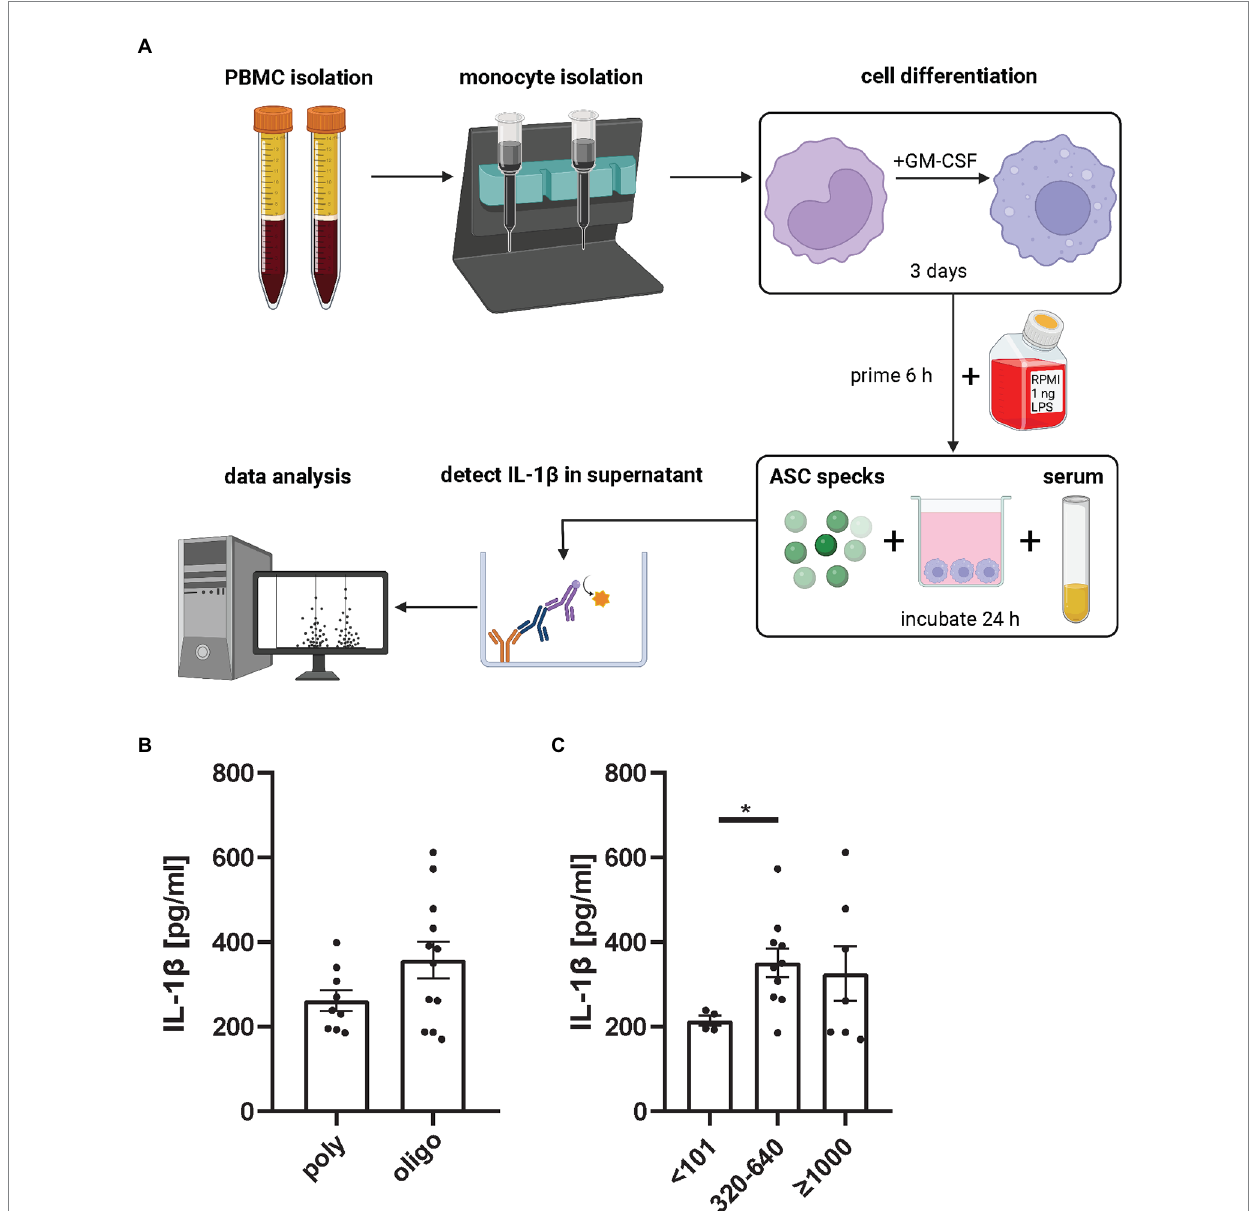
FIGURE 4 ANA + JIA serum incubated with extracellular ASC specks causes primed macrophages to produce significant more IL-1 β than ANA − serum. (A) Monocytes from healthy donors were isolated, differentiated and primed with 1 ng LPS for 6 h and then incubated with ASC specks and patient serum for 24 h. IL-1 β in supernatant was measured (18). Each dot in the bar graphs represents the mean of two independent experiments from 21 oligo- and poly-articular RF negative- JIA patients mean measured in two independent experiment represented as mean from them. Either grouped for their (B) subtype or their (C) ANA Titer. Mann–Whitney U -test was performed, shown mean ± SEM. A p -value * p < 0.05 was considered